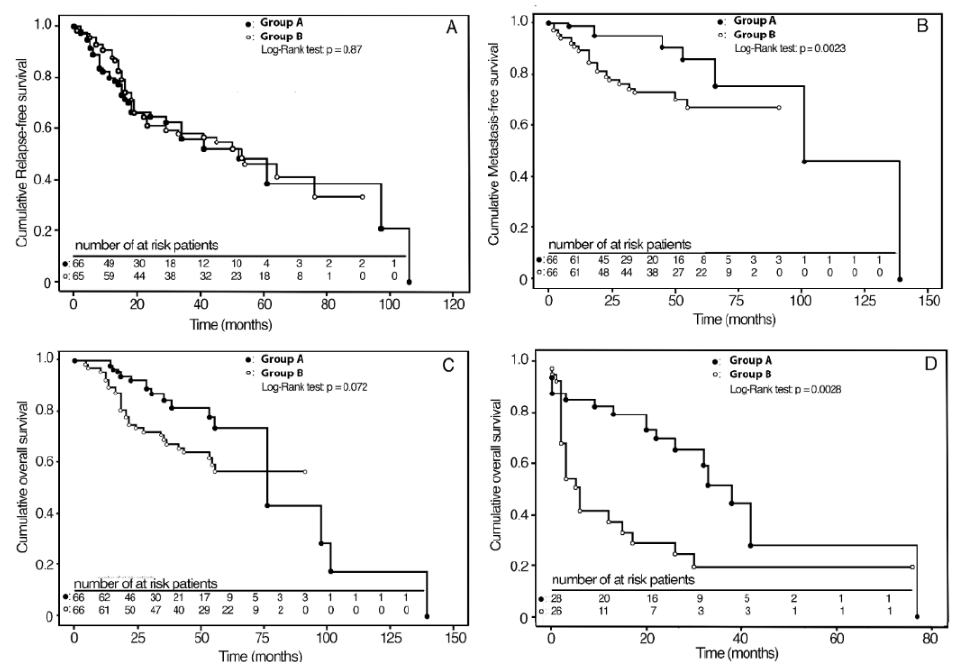
Figure 2. Kaplan–Meier analyses of survival curves for therapy weighted by inverse probability for baseline confounding variables; ( A ) 3-year RFS in groups A and B; ( B ) 3-year MFS in groups A and B; ( C ) 5-year OS in groups A and B; ( D ) 3-year OS in groups A and B after salvage surgery. Table 3. Kaplan–Meier estimates of the survival rates according to the Stage of LALSCC in patients treated with cetuximab + radiotherapy or with up-front surgery + radiochemotherapy.